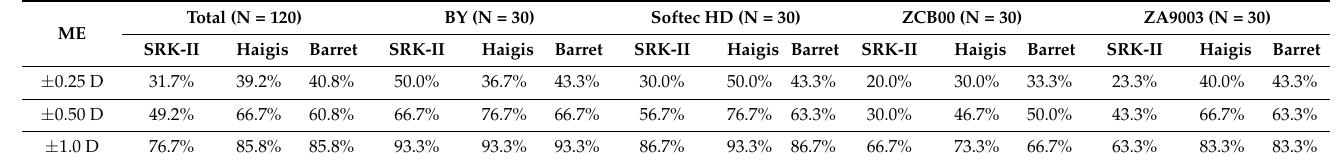
Table 3. Percentage of eyes according to achieved postoperative mean prediction